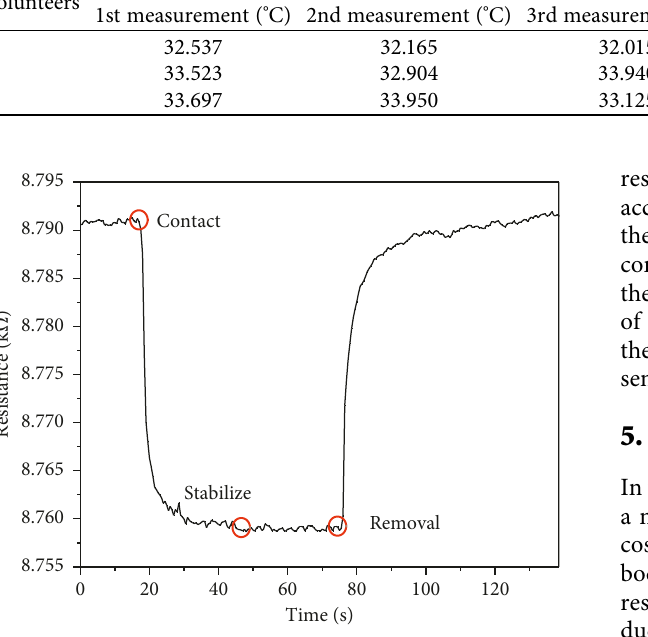
Figure 6: Experimental response time of the sensor in contact with skin to the time.